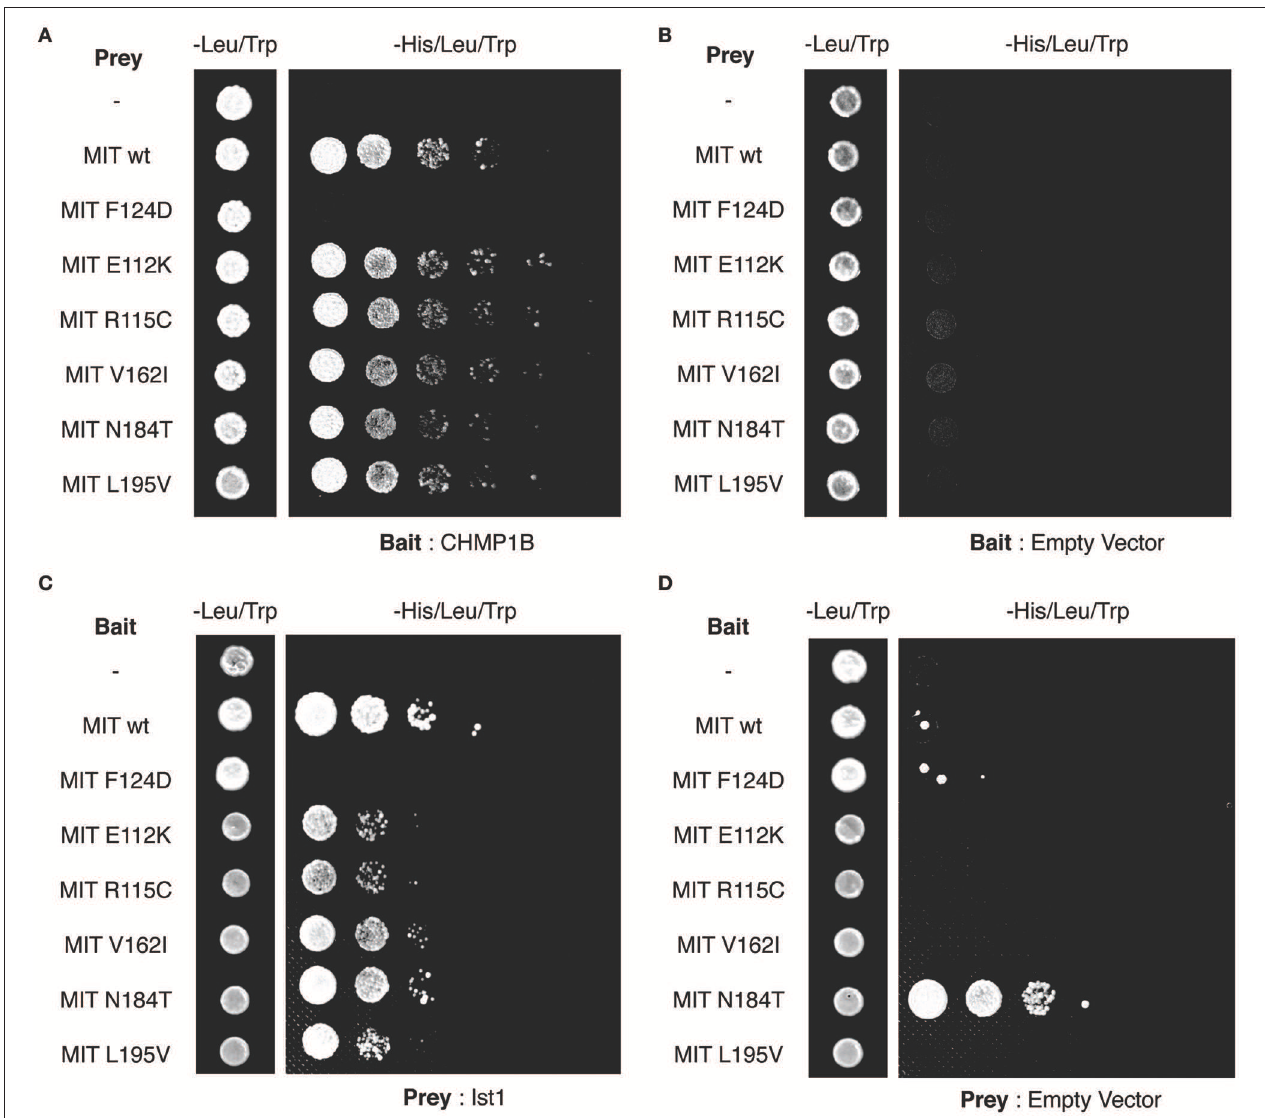
FIGURE 5 | Yeast two-hybrid analysis of spastin MIT domain binding to CHMP1B and IST1. (A–D) Interactions between the combinations of MIT domain, CHMP1B, and IST1 bait and prey vectors indicated in each panel. In each case, the first column shows the growth of diploid colonies on media lacking leucine and tryptophan, to select for the presence of both bait and prey vectors, while columns 2–6 show the growth of serial dilutions of diploid colonies on media lacking leucine, tryptophan, and histidine, which also require the activation of the His reporter gene that occurs on interaction of bait and prey proteins. In (B,D) , empty vector controls test for auto-activation of by the MIT mutant proteins under investigation. Note that the N184T mutant causes auto-activation, and so binding results for this mutant were